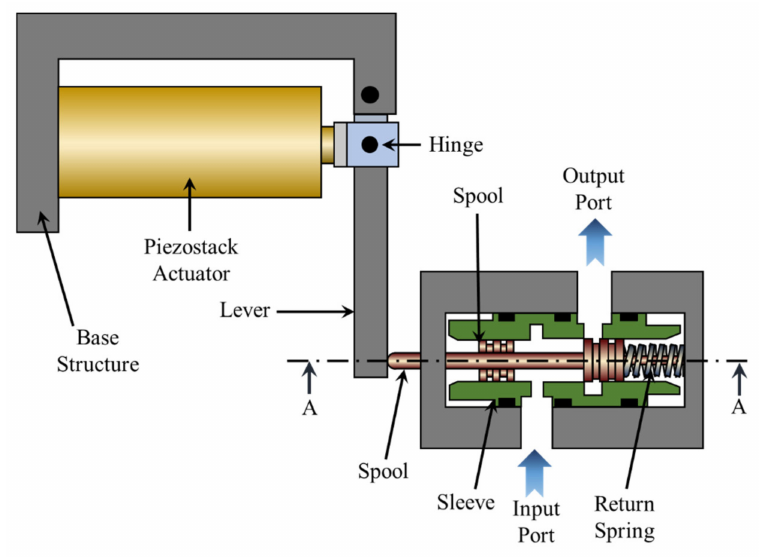
Figure 1. Schematic configuration of the proposed